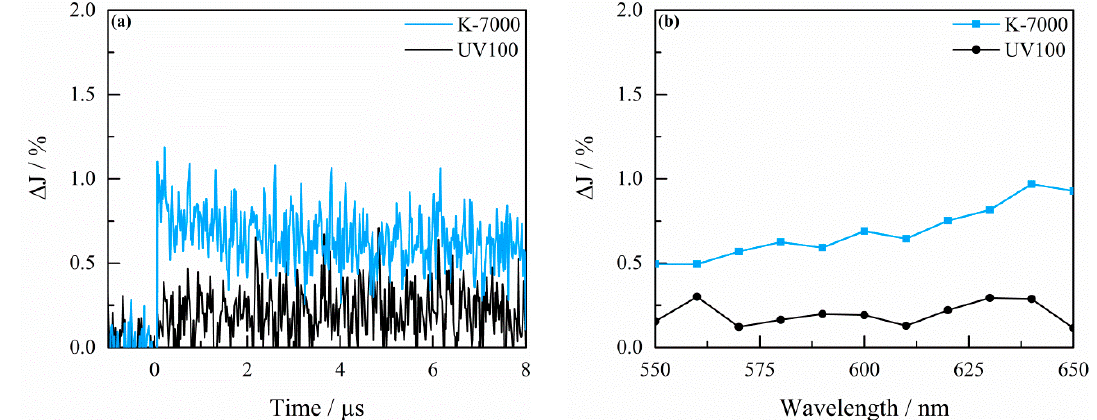
Figure 6. ( a ) Transient absorption decays of K-7000 (blue) and UV100 (black) observed at 650 nm in an Ar atmosphere after excitation with 455 nm, ( b ) transient absorption spectra of K-7000 (blue) and UV100 (black) measured at 100 ns after the laser excitation.